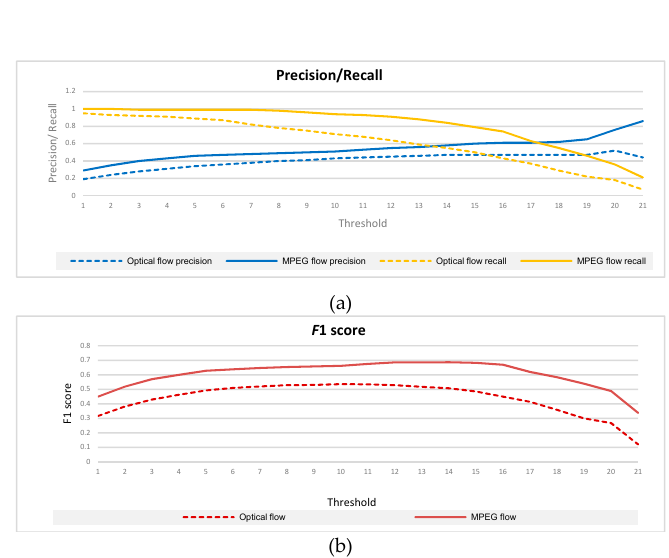
Figure 6. MPEG flow vs. Optical flow classifiers performance. (a) Precision/recall. for different threshold values. (b) F 1 score.